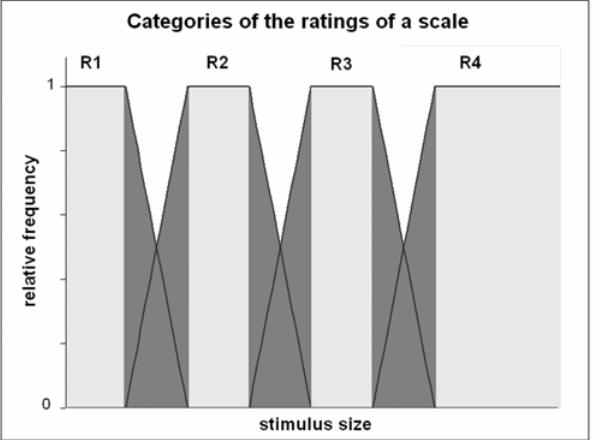
Figure 1. Categories of ratings (idealized). Each rating R1 … R4 corresponds to a curve with a central core where the relative frequency is 1, and peripheries where the relative frequency decreases towards 0 (the trapezoidal curves are only illustrative). Horizontal : Stimulus sizes. Vertical : relative frequency of rating. Light gray : cores. Dark gray :